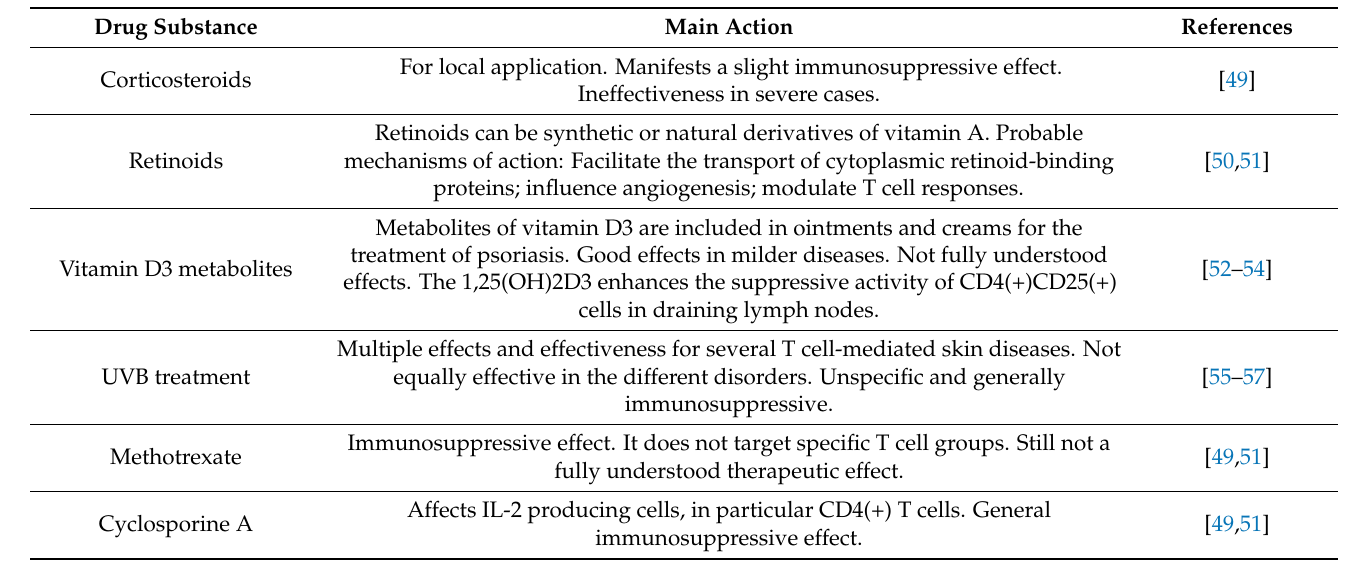
Table 1. Mostly used therapeutic solutions for T cell-mediated skin disorders. Drug Substance Main